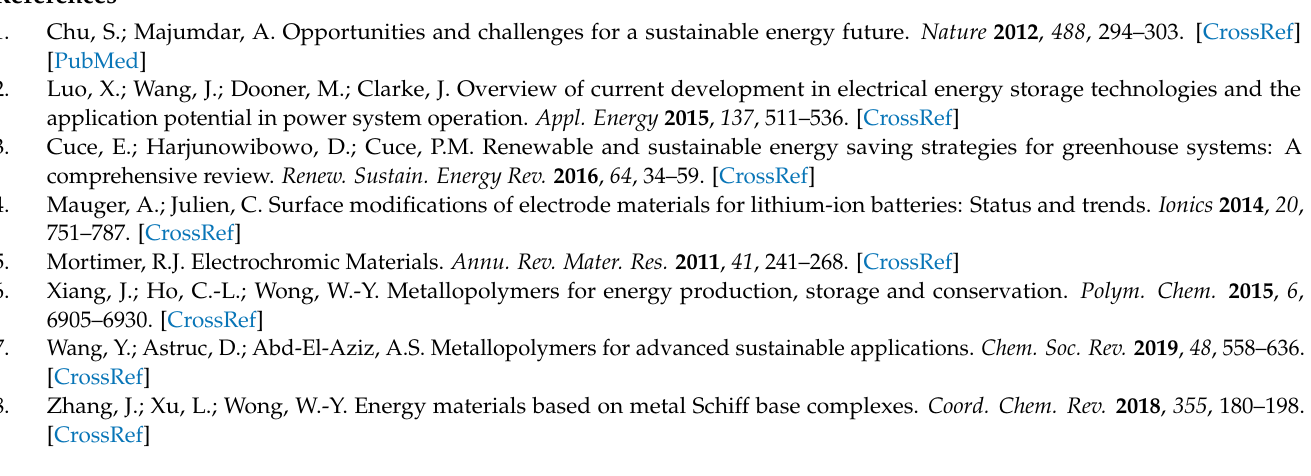
Table S1: Coulombic efficiency of poly-[NiAmben] in the potential range between − 0.9 and 1.3 V in 0.05 M Et 4 NBF 4 /DCE, Figure S3: Dependence of the redox charge ∆ Q on the electrode potential E for the CV curve of poly-[NiAmben] shown in Figure 6b, Figure S4: Mass–charge plots for the EQCM test of poly-[NiAmben] shown in Figure 6b: ( a ) polymer oxidation; ( b ) polymer reduction, Table S2: Effective molar mass of electrolyte species, M red , and the number of electrons per repeat unit, n, exchanged during voltammetric reduction of poly-[NiAmben] in 0.05 M Et 4 NBF 4 /DCE at 0.01 V s − 1 scan rate, Figure S5: UV-Vis spectra of a poly-[NiAmben]-modified ITO-coated glass electrode collected in 0.05 M Et 4 NBF 4 /DCE in the potential range from − 0.9 to 1.3 V, Figure S6: Differential UV-Vis spectra of a poly-[NiAmben]-modified ITO-coated glass electrode during redox switching in 0.05 M Et 4 NBF 4 /DCE: ( a ) spectra from − 0.8 to − 0.4 V, referenced to the spectrum of the polymer at − 0.9 V; ( b ) spectra from − 0.3 to 0.0 V, referenced to the spectrum of the polymer at − 0.4 V; ( c ) spectra from 0.1 to 0.3 V, referenced to the spectrum of the polymer at 0.0 V; ( d ) spectra from 0.4 to 0.8 V, referenced to the spectrum of the polymer at 0.3 V; ( e ) spectra from 0.9 to 1.3 V, referenced to the spectrum of the polymer at 0.8 V, Figure S7: UV-Vis spectra of a poly-[NiSalen]-modified ITO-coated glass electrode at − 0.3 V acquired in 0.05 M Et 4 NBF 4 /DCE (black curve 1) and the spectrum of [NiSalen] monomer (red curve 2), Figure S8: CV curves of a poly-[NiSalen]-modified Pt-coated quartz crystal electrode (1.37 cm 2 ) in 0.05 M Et 4 NBF 4 /DCE between − 0.3 and 1.3 V at different scan rates (0.005–0.2 V s − 1 ), Table S3: Coulombic efficiency of poly-[NiSalen] in the potential range between − 0.3 and 1.3 V in 0.05 M Et 4 NBF 4 /DCE at different scan rates (calculated from the CV data shown in Figure S8), Figure S9: The color change of the poly-[NiSalen] film with varying